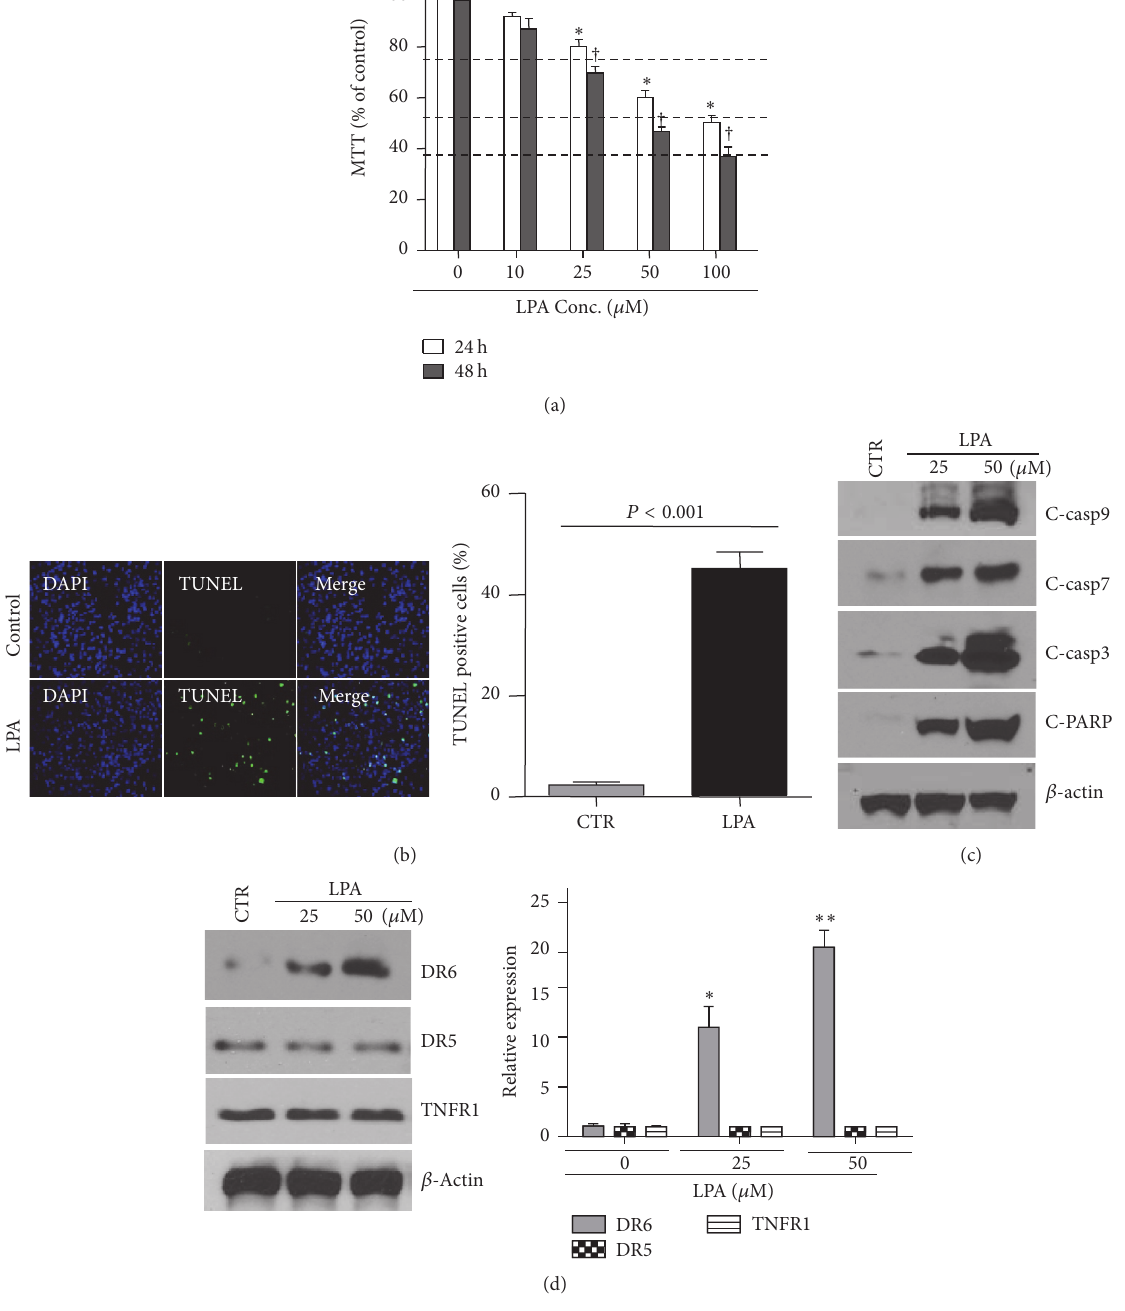
Figure 1: LPA induces apoptosis accompanied by upregulation of DR6 expression. (a) LPA treatment reduced cell viability in a concentration- dependent manner as determined by MTT assay. 10–25 𝜇 M LPA-induced significant cell viability reduction compared to control. 𝑛 = 4 , ∗ 𝑃 < 0.05 versus control; † high concentration of LPA at 50–100 𝜇 M caused more cell viability reduction. 𝑛 = 4 . (b) LPA-triggered apoptosis was determined by TUNEL staining. HeLa cells were treated by 25 𝜇 M LPA for 24 hrs. 𝑛 = 3 . The bar graphs on the right panel represent quantification of TUNEL assay, 𝑛 = 3 , 𝑃 < 0.001 versus control. (c and d) HeLa cells were exposed to different concentration of LPA for 18 hours. Activation of caspase-9, caspase-7, and caspase-3 and the cleavage of PARP (c), and expression levels of DR6, DR5, and TNFR (d) were determined by Western blot. The blot is a representative of 4 blots from 4 independent experiments ( 𝑛 = 4 ). The bar graphs on the right panel are densitometry analyses of DR6, DR5, and TNFR1 protein expression. ∗ 𝑃 < 0.05 , ∗∗ 𝑃 < 0.001 versus